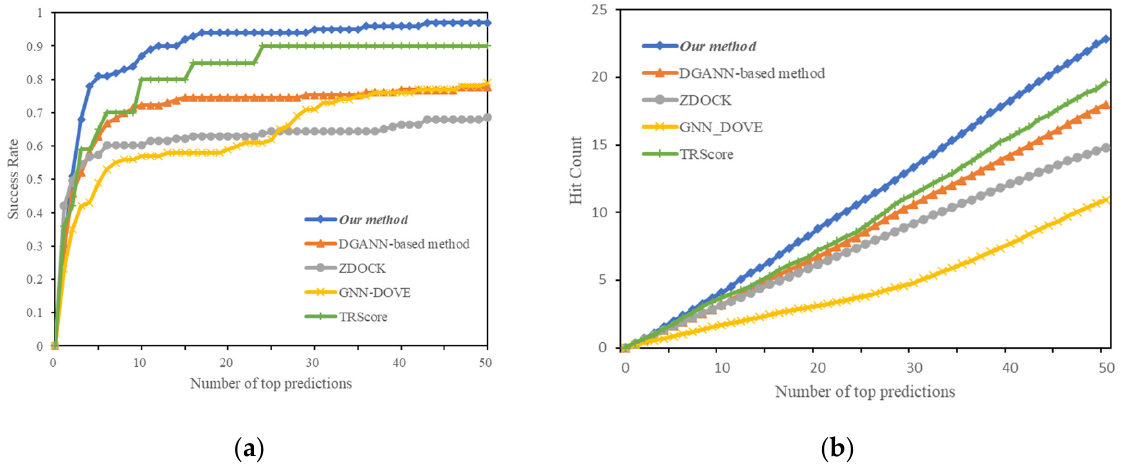
Figure 4. Comparison of our scoring function with DGANN-based method, ZDOCK,GNN-DOVE and TRScore for the cross-validation ZDOCK benchmark 4.0. ( a ) Success rates of di ff erent methods. ( b ) Hit counts of di ff erent methods.